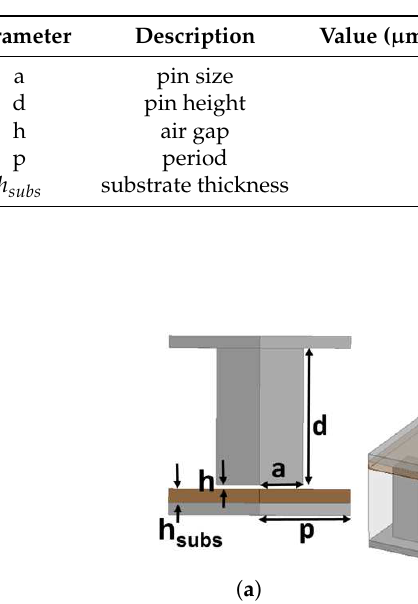
Table 1. Dimensions of the bed of nails used in the two proposed transitions.